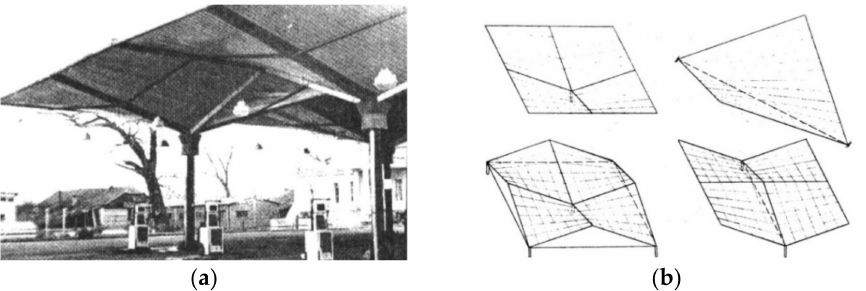
Figure 4. Symmetrically arranged hyperbolic paraboloid units: ( a ) an erected corrugated umbrella shed; ( b ) various configurations of umbrella shell structures.